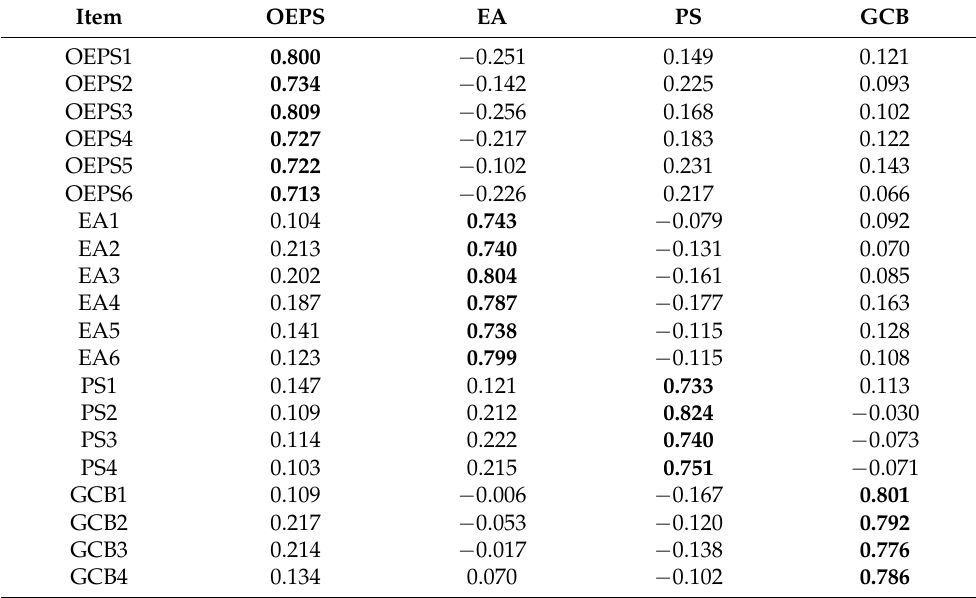
Table 3. The results of the exploratory factor analysis.